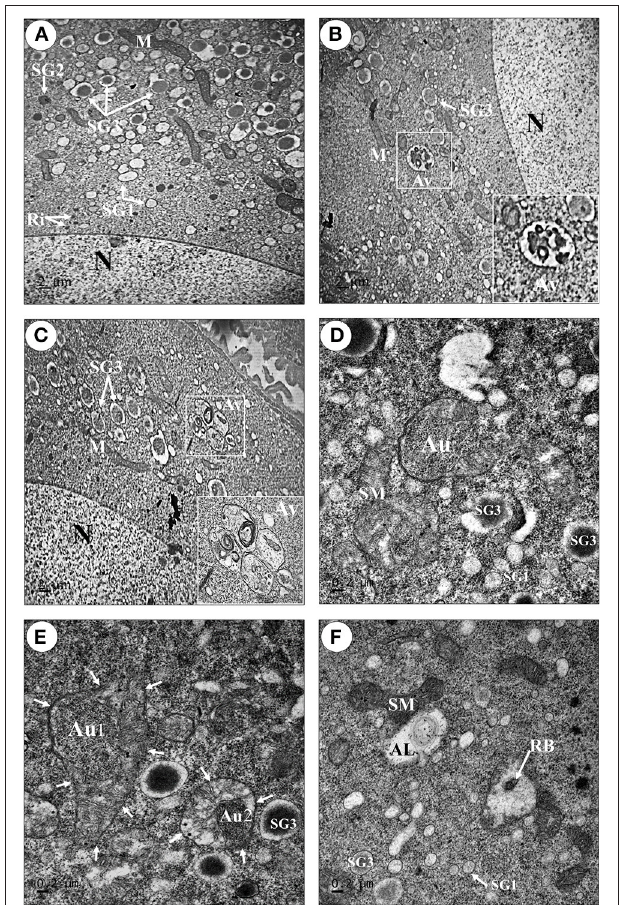
FIGURE 6 | Transmission electron micrographs showing an increase in number of autophagic vacuoles in the late stage oocytes of starved prawns. An oocyte (Oc4) of fed prawn (A) showed euchromatic nucleus (N) and cytoplasmic organelles including mitochondria (M), ribosomes (Ri), and three types of secretory granule, whereas in addition to these organelles the oocytes of starved prawn (B–F) exhibited an increase in number of swollen mitochondria (SM), phagophore assembly site (PAS) which was suggestive of the early step in the formation of autophagosome (Au) ( D,E ; Au1), PAS eventually closed and engulfed the mitochondrion forming complete Au ( E ; Au2). Autolysosome (AL) and residual body (RB) were also observed in the cytoplasm of starve prawn. SG1, secretoty granule type1; SG2, secretory granule type2; SG3, secretoty granule type3. Bar 2 µ m (A–C) , 0.2 µ m (D–F)